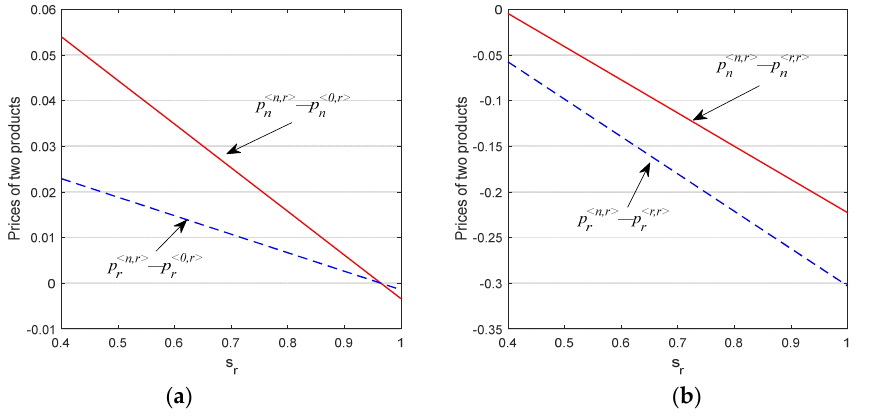
Figure 4. Price comparison under two subsidies policy. ( a ) < n , r > and < 0 , r >. ( b ) <n , r> and < r , r >.